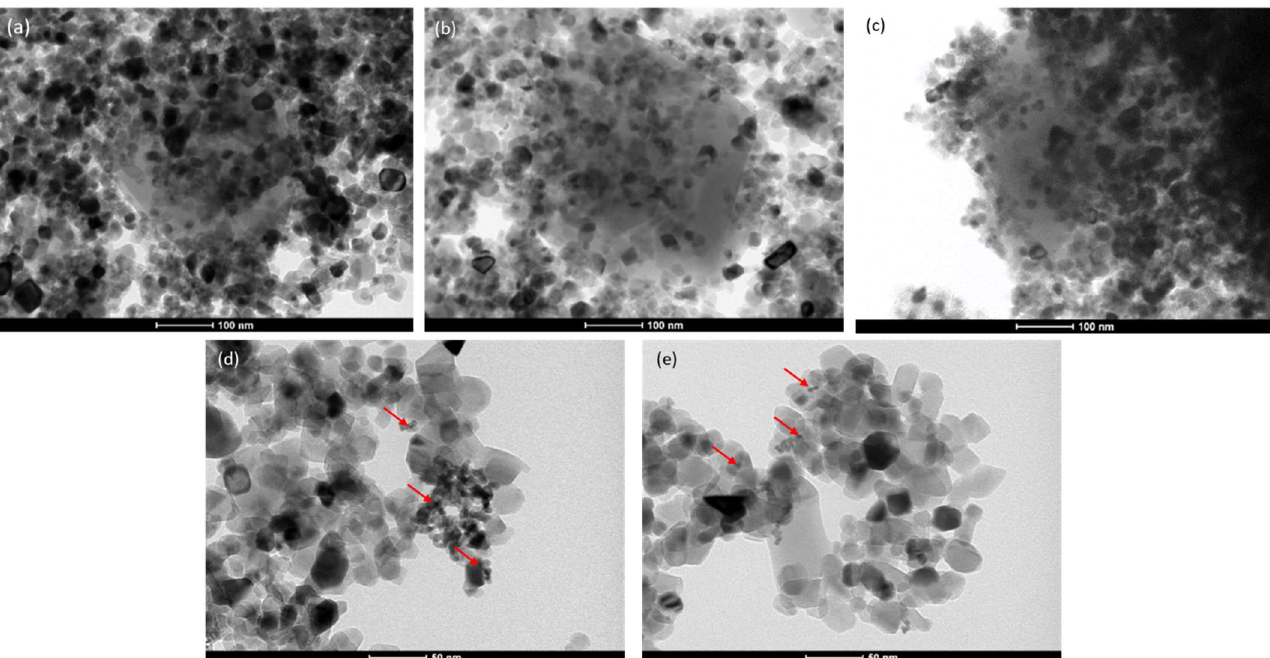
Figure 2. TEM images of ( a ) T–ZY, ( b ) T–ZY–Pd, ( c ) T–ZY–Ag, and higher magnification of ( d ) T–Pd and ( e ) T–ZY–Pd. Arrows indicate the presence of Pd-containing nanoparticles/clusters.